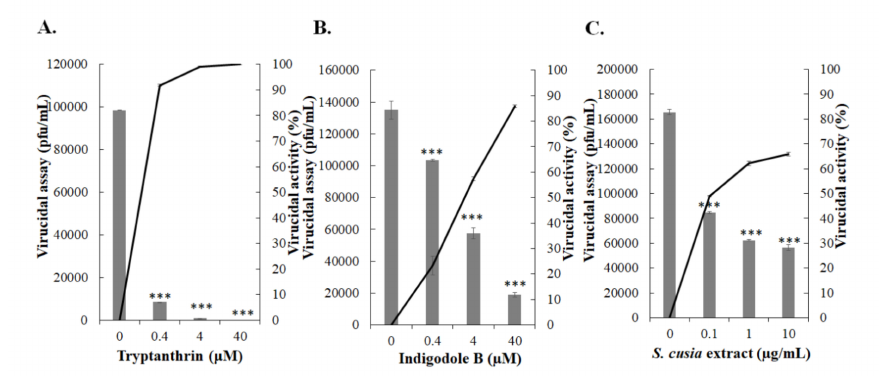
Figure 10. Virucidal activity of tryptanthrin, indigodole B, and S. cusia extract. Tryptanthrin ( A ), indigodole B ( B ), or the extract ( C ) at the indicated concentrations was mixed with HCoV-NL63 (10 5 pfu), and incubated at 37 ◦ C for 1 h. The 1000-fold dilution of the compound / virus mixture was added into the LLC - MK2 cell monolayer in 6-well plates for examining the residual infectivity by plaque assay. Virucidal activity was calculated based on the percentage of residual plaques in each treated group. ***, p value < 0.001 compared with untreated infected cells.